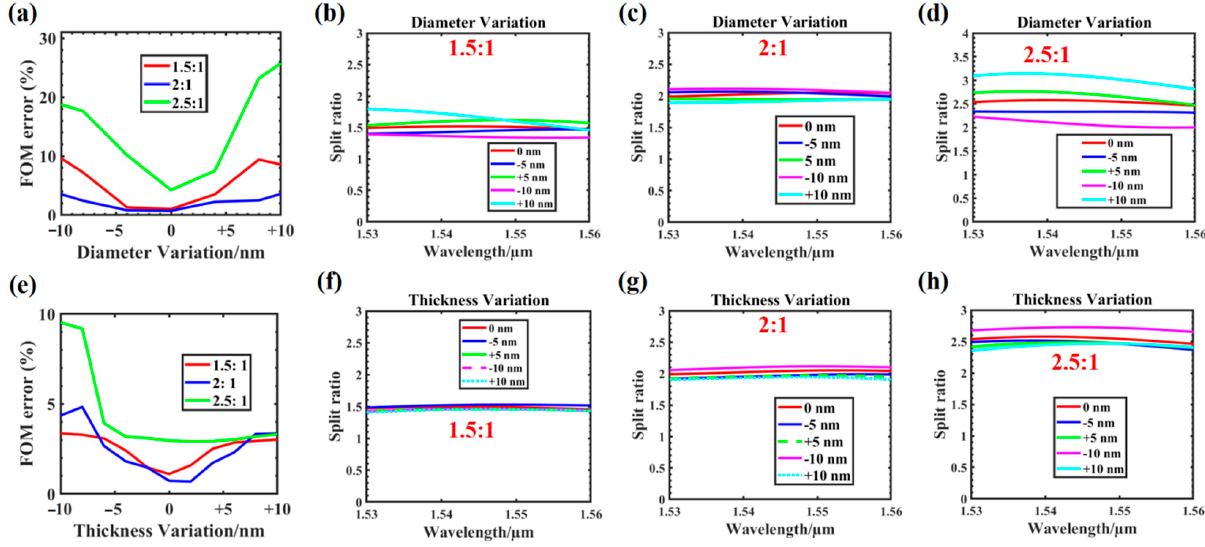
Figure 9. Analysis of the fabrication tolerances for the 1 × 2 photon programmable power splitter: ( a ) simulated FOM error as the hole radius varied from − 10 to +10 nm; ( b – d ) simulated power–split ratio as the hole radius varied from − 10 to +10 nm; ( e ) simulated FOM_error of the top layer of silicon as its thickness varied from − 10 to 10 nm; ( f – h ) simulated power–split ratio of the top layer of silicon as its thickness varied from − 10 to 10 nm.